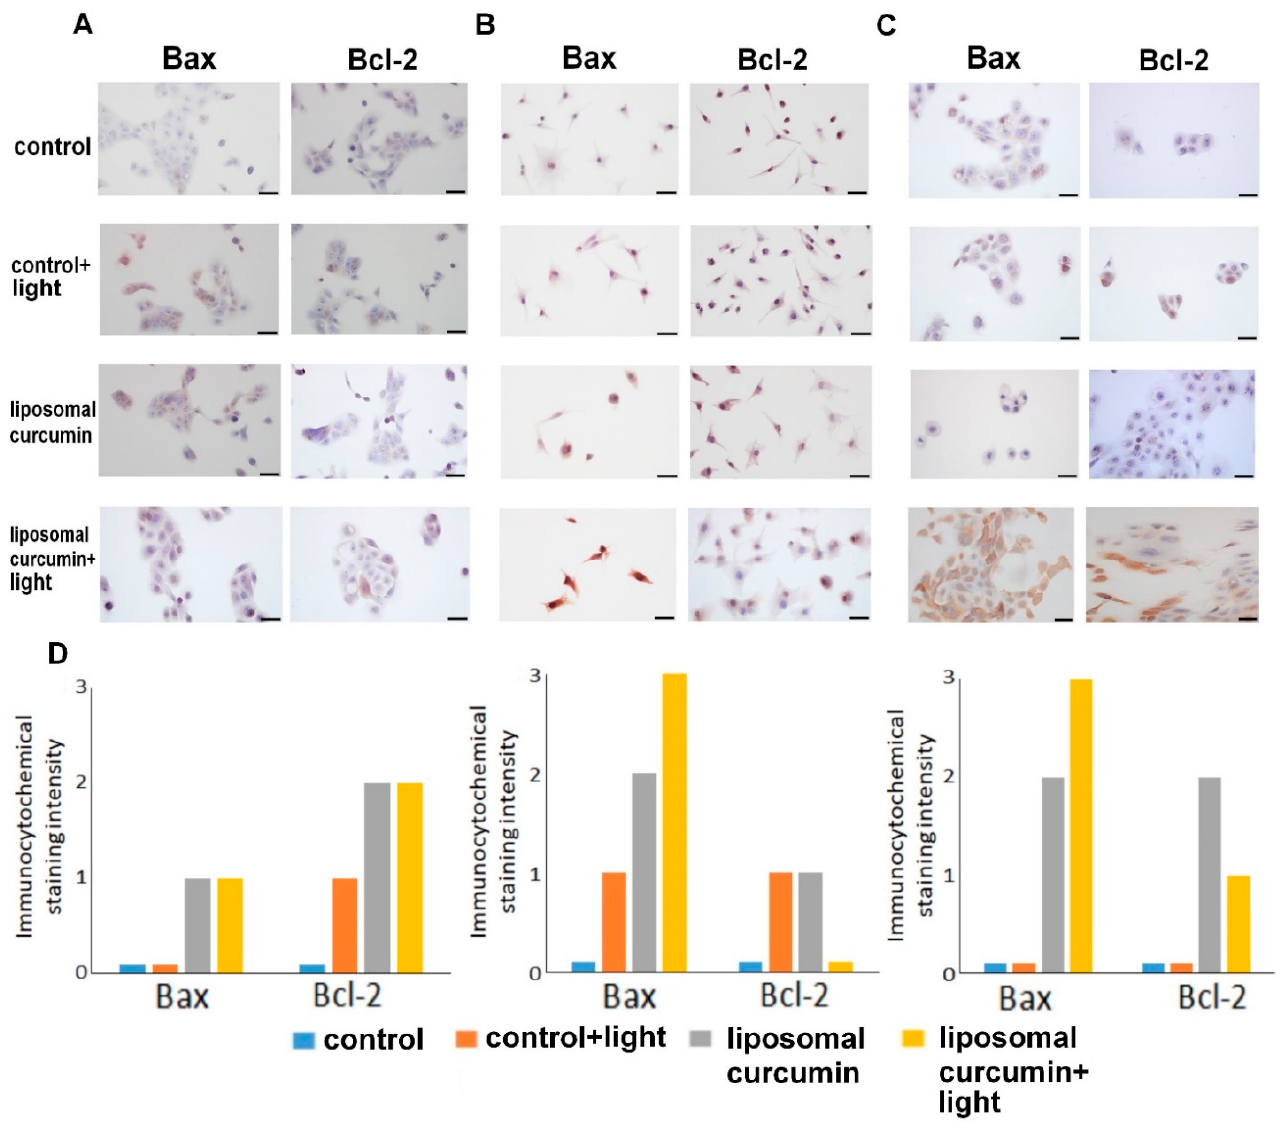
Figure 4. Presenting immunocytochemical staining of the chosen apoptosis-related proteins Bax and Bcl-2 in HaCaT ( A ), MUG-Mel2 ( B ), and SCC-25 ( C ) cells lines in four conditions: control, control with blue light only, liposomal curcumin in dose 10 µ M, and liposomal curcumin in dose 10 µ M with a low dose of blue light (2.5 J/cm 2 ). ( D ) Results of immunocytochemical analysis of HaCaT, MUG-Mel2, and the SCC-25 cell line and the chosen apoptosis-related protein expression calculated by the immunoreactivity score. Abbreviations: 0-no staining, 1-weak staining, 2-moderate staining, and 3-strong staining. Scale bar = 50 µ